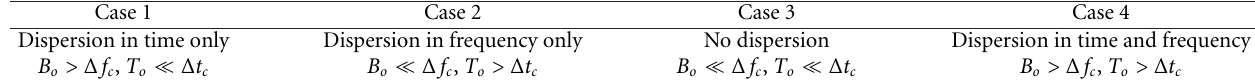
Table 1: Summary of the possible MC-DS-CDMA cases in regard to interaction with the channel. Case 1 Case